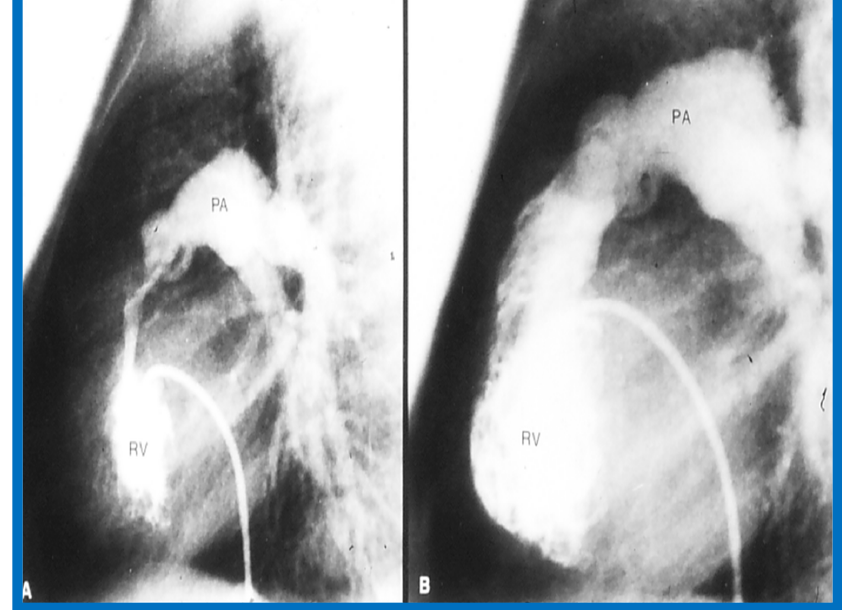
Figure 48. Selected right ventricular (RV) cineangiographic frames from lateral